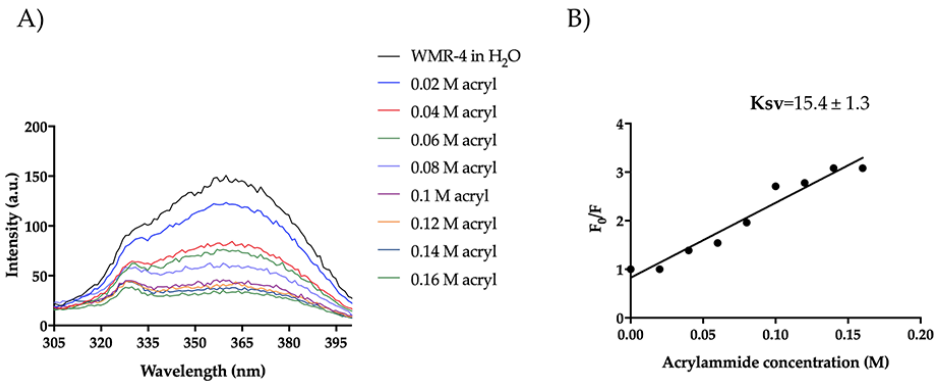
Figure 11. Tryptophan fluorescence spectra for the peptide WMR-4 in water during the quenching with acrylamide at different concentrations ( A ) and Stern–Volmer (Ksv) quenching constant ( B ).